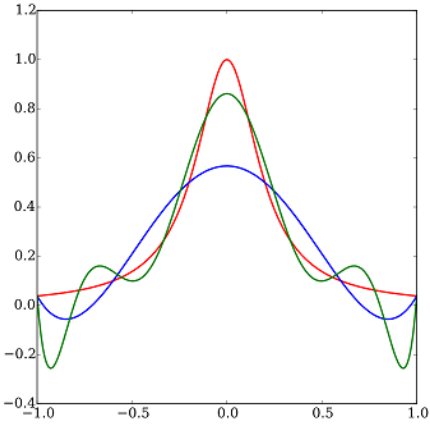
Figure 6. Runge’s phenomenon of oscillation for polynomial models of 3 and higher degrees—the abscissa shows the degree of the model and the ordinate shows the error of the results in percentage, giving the same accuracy results and extra calculations are not required; red, blue and green curves is a polynomial models of corresponding degree.